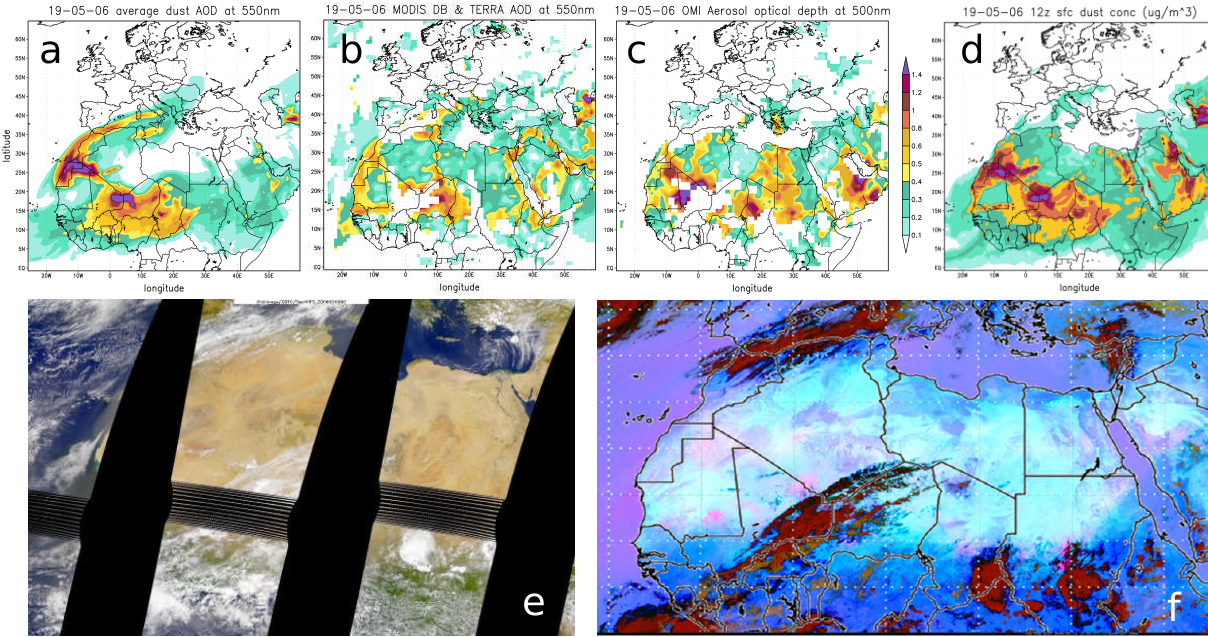
Fig. 5. The same as in Fig. 2, but for 19 May 2006.